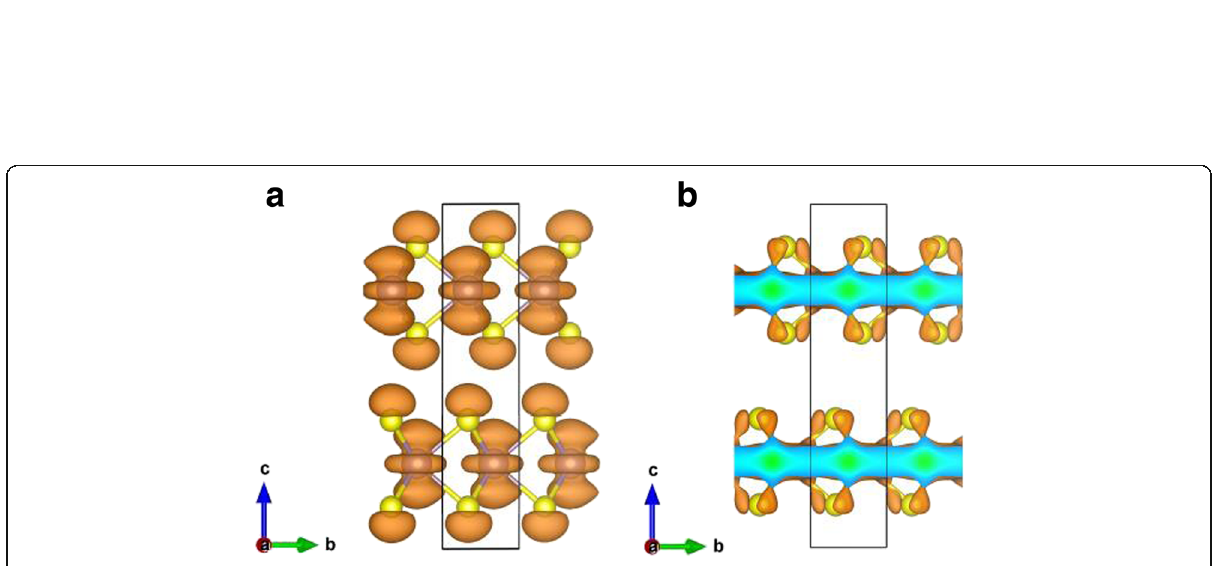
Fig. 4 The charge distributions of the highest occupied band at a point and b point K for bulk MoS 2 . The isosurface value is set to be 0.004 e/Å